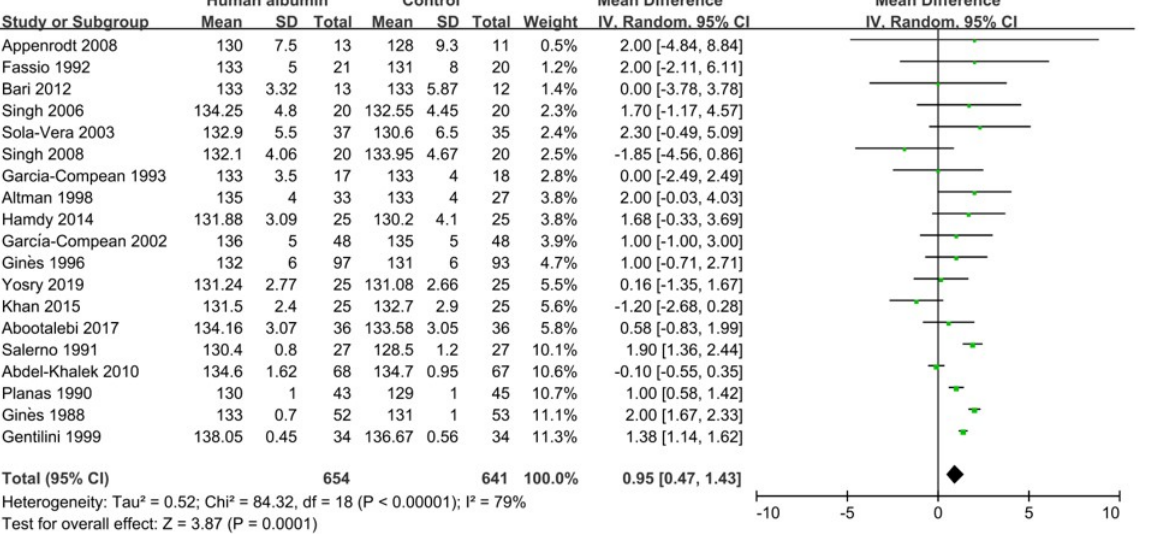
Figure 4. Forrest plots showing the effect of human albumin infusion on serum sodium level in liver cirrhosis without hyponatremia.